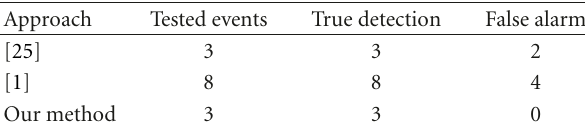
Table 2: Comparison of AVSS2007 dataset.